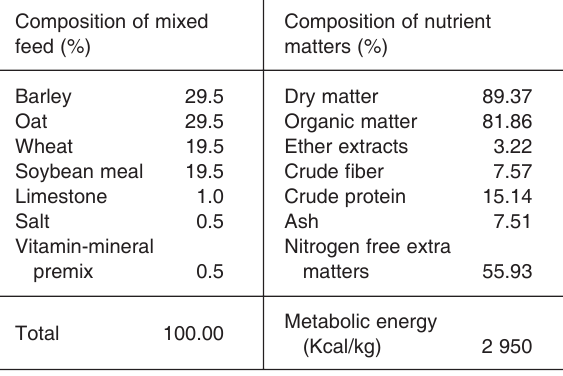
TABLE 1 Composition of mixed feed and nutrient matters of ostriches Composition of mixed